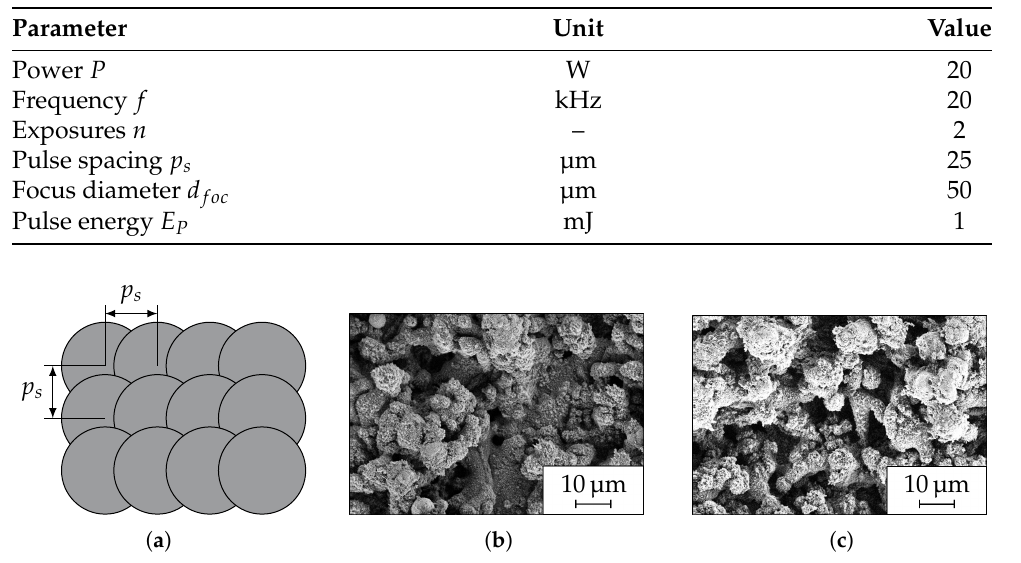
Figure 2. Illustration of the pulse pattern for a chaotic nanostructure ( a ) and scanning electron microscope (SEM) images (acceleration voltage of 1kV) of the generated structures on EN AW-2024- T3 ( b ) and EN AW-6082-T6 ( c ).